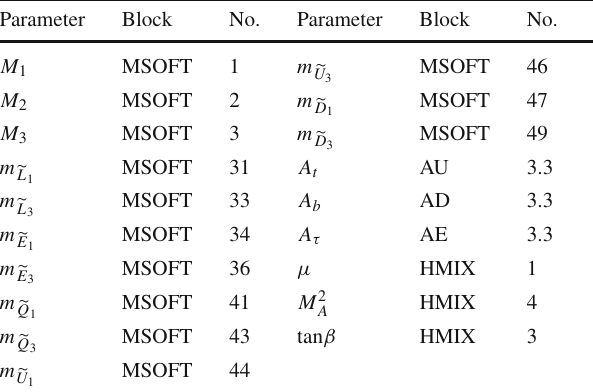
Table 4 Variables used for training in the pMSSM. The variables are identified according to the SLHA-1 standard [74], given in order used